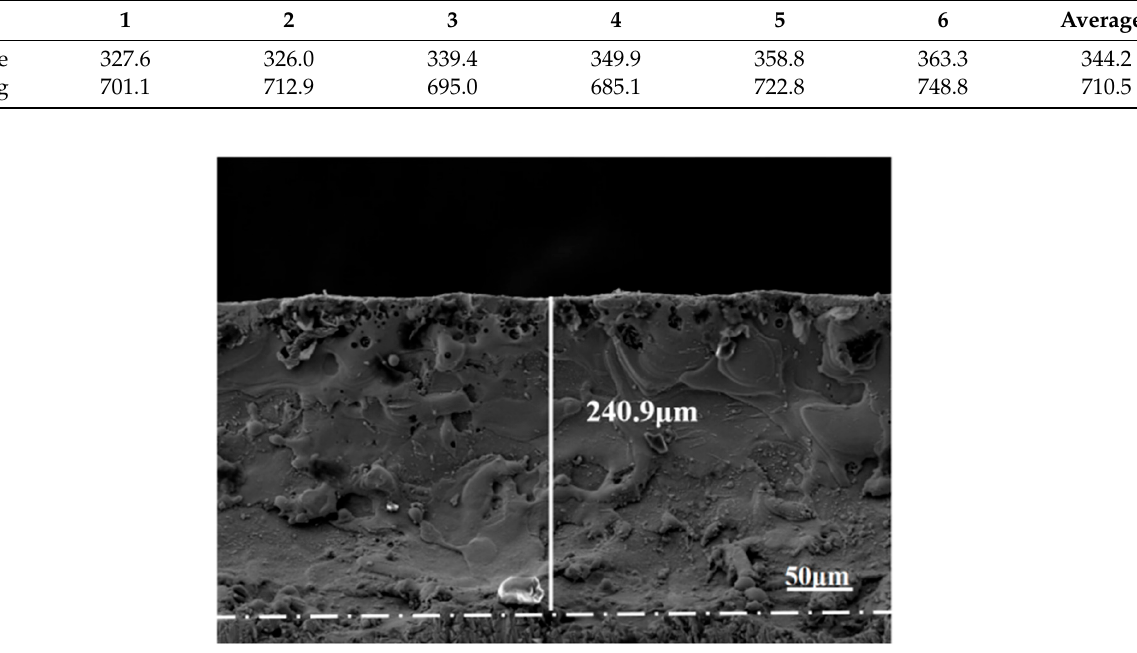
Figure 7. Substrate 4Cr10Si2Mo and nitrided 4Cr10Si2Mo element XPS fi ne spectrum. ( a ) Fine spectrum of surface Fe before and after nitriding. ( b ) Fine spectrum of surface Cr before and after nitriding. ( c ) Fine spectrum of surface N before and after nitriding.